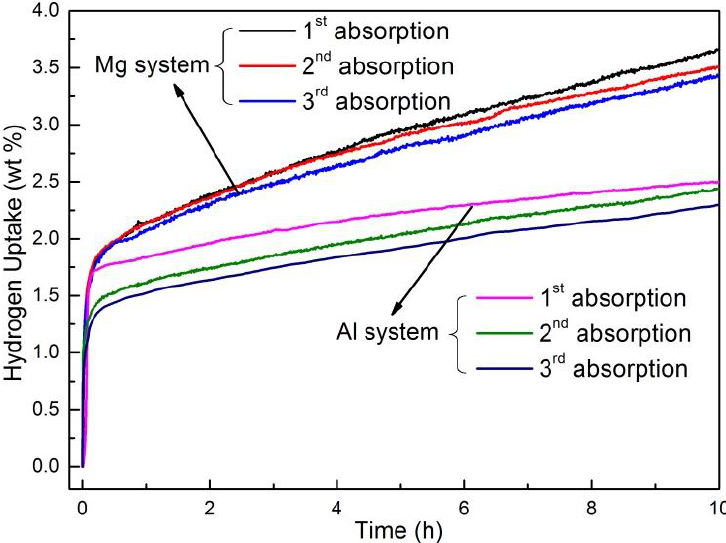
Figure 7. Hydrogenation and dehydrogenation curves for the 2NaF–MgB 2 (AlB 2 )–0.05TiF 3 systems on cycling at 500 °C and 6 MPa hydrogen pressure [59]. Reproduced from [59] by permission of The Royal Society of